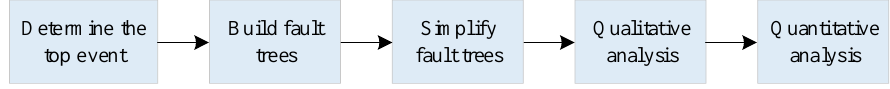
Figure 4. Block diagram of the reliability assessment method.